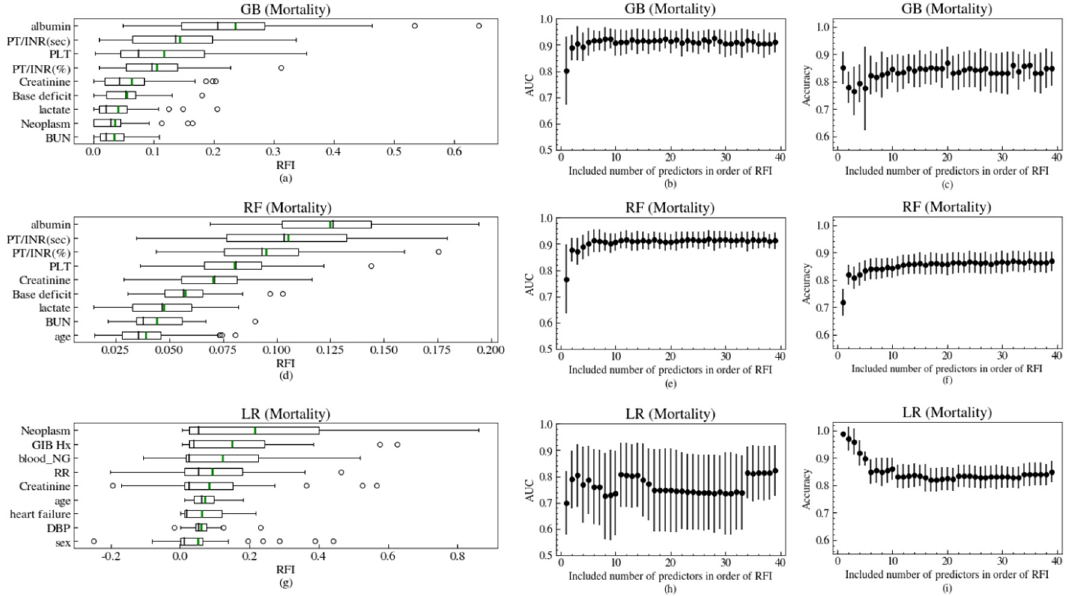
Figure 3. ( a ), ( d ), and ( g ) are the relative feature importance (RFI) of the top nine features predicting mortality by the three machine learning algorithms: LR , RF, and GB respectively. The black lines in boxes show the median of RFI and green lines show the mean of RFI. The AUC of the three models, with the included number of predictors in the order of RFI to predict mortality, are plotted in ( b ), ( e ), and ( h ). The accuracies of the three models, according to the included number of predictors in the order of RFI to predict mortality, are also plotted in ( c ), ( f ), and ( i ). The means of the AUC and accuracy are shown as black dots and the 1 standard deviation ranges from them are shown as black error-bars. See Table A1 for variable names. The cases of true-negatives, true-positives, false-positives, and false-negatives by the RF were used to explain the prediction of mortality with LIME interpretation in Figure 4. The four cases were selected from the test-set randomly. Only the eight most important features in predicting mortality for an individual patient were shown for simplicity. In cases of true-negatives (Figure 4a), the values of coagulopathy, prothrombin ratio/international normalized ratio (PT/INR) (sec), age, and PT/INR (%) supported a low probability of mortality in the patients, but the values of albumin, creatinine, base deficit, and hemoglobin supported the positive prediction. In the case of true-positives, the values of albumin, creatinine, base deficit, PT/INR (%), and PT/INR (sec) in Figure 4b support a high chance of mortality of the patients. In cases of false-negatives (Figure 4c), it looked vague for predicting the possibility of mortality with a distribution of eight feature values. The values of hemoglobin, PT/INR (sec), and PT/INR (%) contradict the risk of mortality of the patients, but the values of albumin, creatinine, platelet count, coagulopathy, and respiratory rate denied the decision. The last case (Figure 4d) showed that the values of all features except coagulopathy and previous gastrointestinal history explained the high risk of mortality, but it actually did not as it was a false-positive. Despite this false-positive case, the RF seemed to have made the right decision for mortality of patients based on the predicted variable distribution. Almost statistically significant variables for the mortality of patients appeared again in the LIME explanation diagram. The four cases of LIME explainability of hypotension and rebleeding within 7 days are shown in Figures S3 and S4.